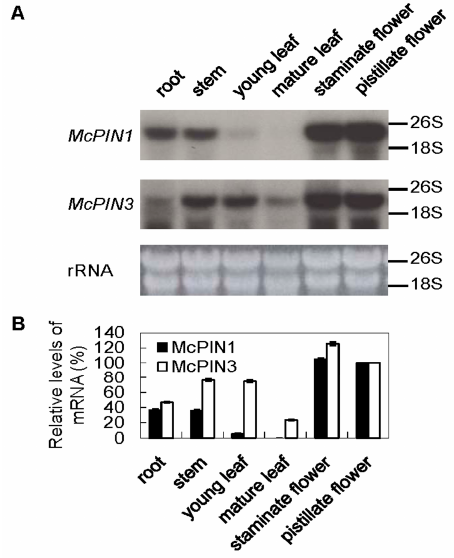
Figure 4. Tissue specificity of auxin efflux carrier genes. ( A ) Photograph and expression patterns of McPIN1 and McPIN3 mRNAs in different organs of bitter gourd. Each lane contained 20 µg of total RNA isolated from different organs. Northern blot analysis was performed with 32 P-radiolabeled insert of cDNA clone pMAEC43 (for McPIN1 ) and pMAEC93 (for McPIN3 ); ( B ) Hybridization signals were quantified by using LabWorks bioimaging system. The expression level in each treatment was normalized to the 26S and 18S loading control; the maximum level was set to 100%, and all other organ points were normalized to it. Relative expression was determined in triplicate measurements in three independent biological replicates. Error bars represent the standard deviation.